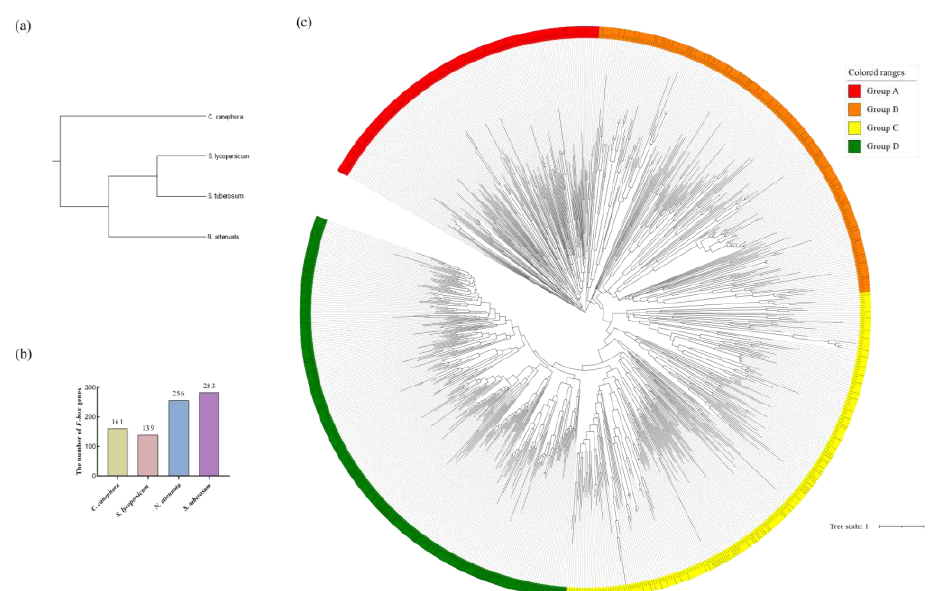
Figure 2. Phylogenetic relationship of F-box gene family. ( a ) Phylogenetic tree of 4 species. ( b ) Number distribution of F-box members in 4 species. ( c ) Phylogenetic relationships of F-box proteins identified in S. lycopersicum , N. attenuata , S. tuberosum and C. canephora .